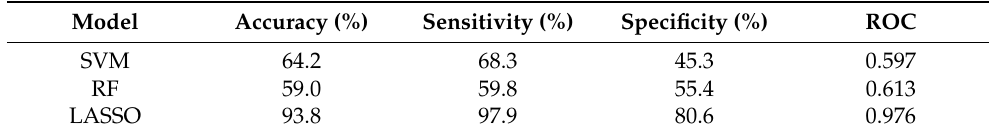
Table 2. Performance comparison of adopted models (k = 10).